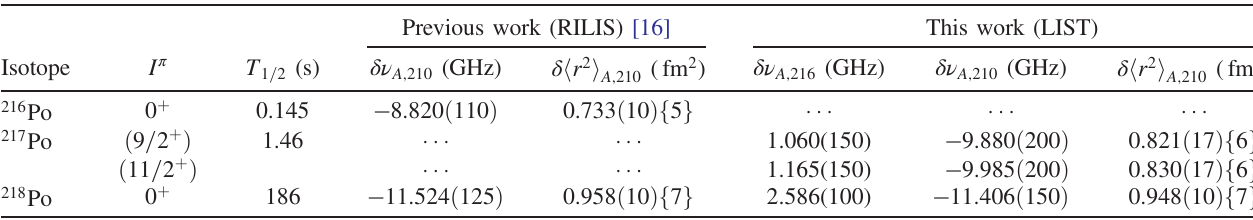
TABLE I. Isotope shifts δν and changes in the mean-square charge radii δ h r 2 i of 216 ; 217 ; 218 Po. The results for 216 ; 218 Po from A; 216 . Statistical uncertainties are given in parentheses, previous RILIS measurements [16] are shown for comparison and to calculate δν A; 210 and systematic uncertainties originating from the atomic parameters are given in the curly brackets. For 217 Po, the results for fitting with both I ¼ 9 = 2 and 11 = 2 are presented, showing no significant difference.